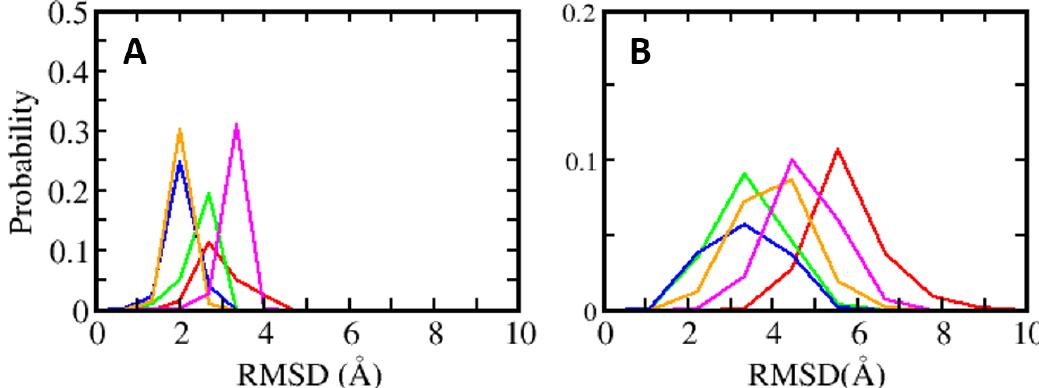
Figure 3. Distributions of root mean square deviation (RMSD) of ( A ) S100B(ββ) ( B ) and the bound peptides (red: NDR, green: RAGE, blue: RSK_PEP1, orange: RSK_PEP2, magenta: TRTK12).